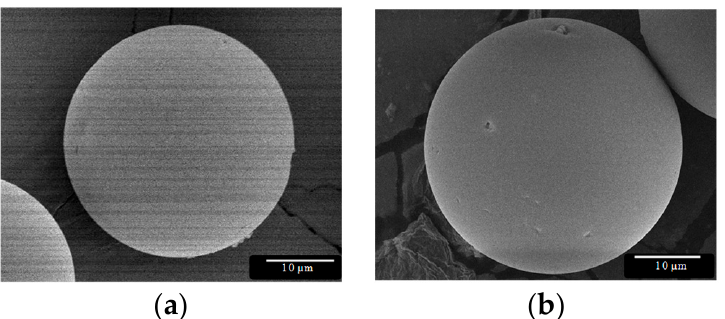
Figure 3. SEM pictures of dexamethasone-loaded PLGA microspheres: ( a ) before and ( b ) after γ -irradiation (applied dose: 25 kGy).